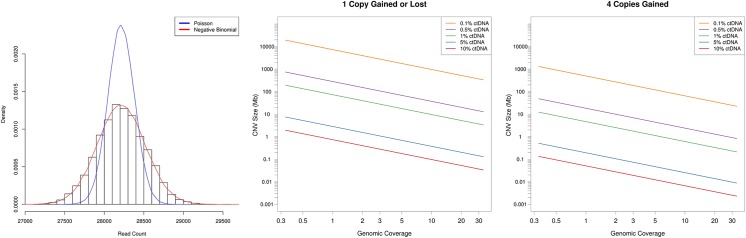
Theoretical limits of ctDNA CNV detection.A) Density plot for healthy donor cfDNA sequencing reads mapped to 10kb genomic bins. A negative binomial (red) and Poisson (blue) distribution was fit to the resultant data. B) The ctDNA CNV size limit of detection (in megabases) is plotted as a function of sequencing depth for single copy change at various ctDNA fractions. C) Same as panel B but for four copies gained.